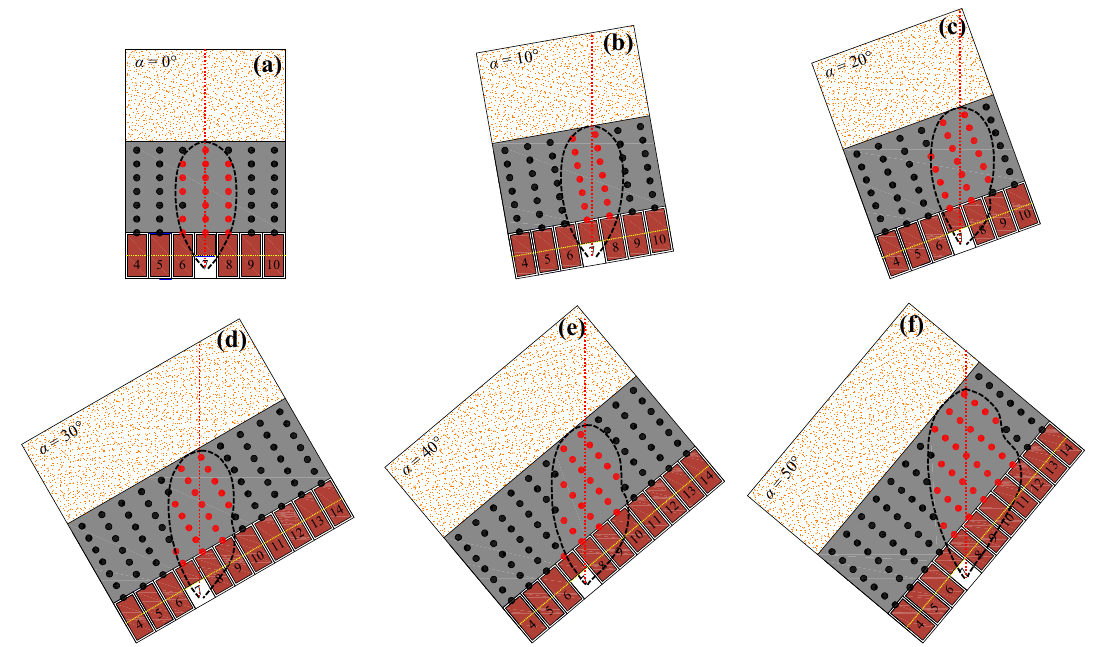
Fig. 4 Inversion of the drawing body shape in the initial drawing stage: a a = 0 (cid:3) ; b a = 10 (cid:3) ; c a = 20 (cid:3) ; d a = 30 (cid:3) ; e a = 40 (cid:3) ; f a = 50 (cid:3)